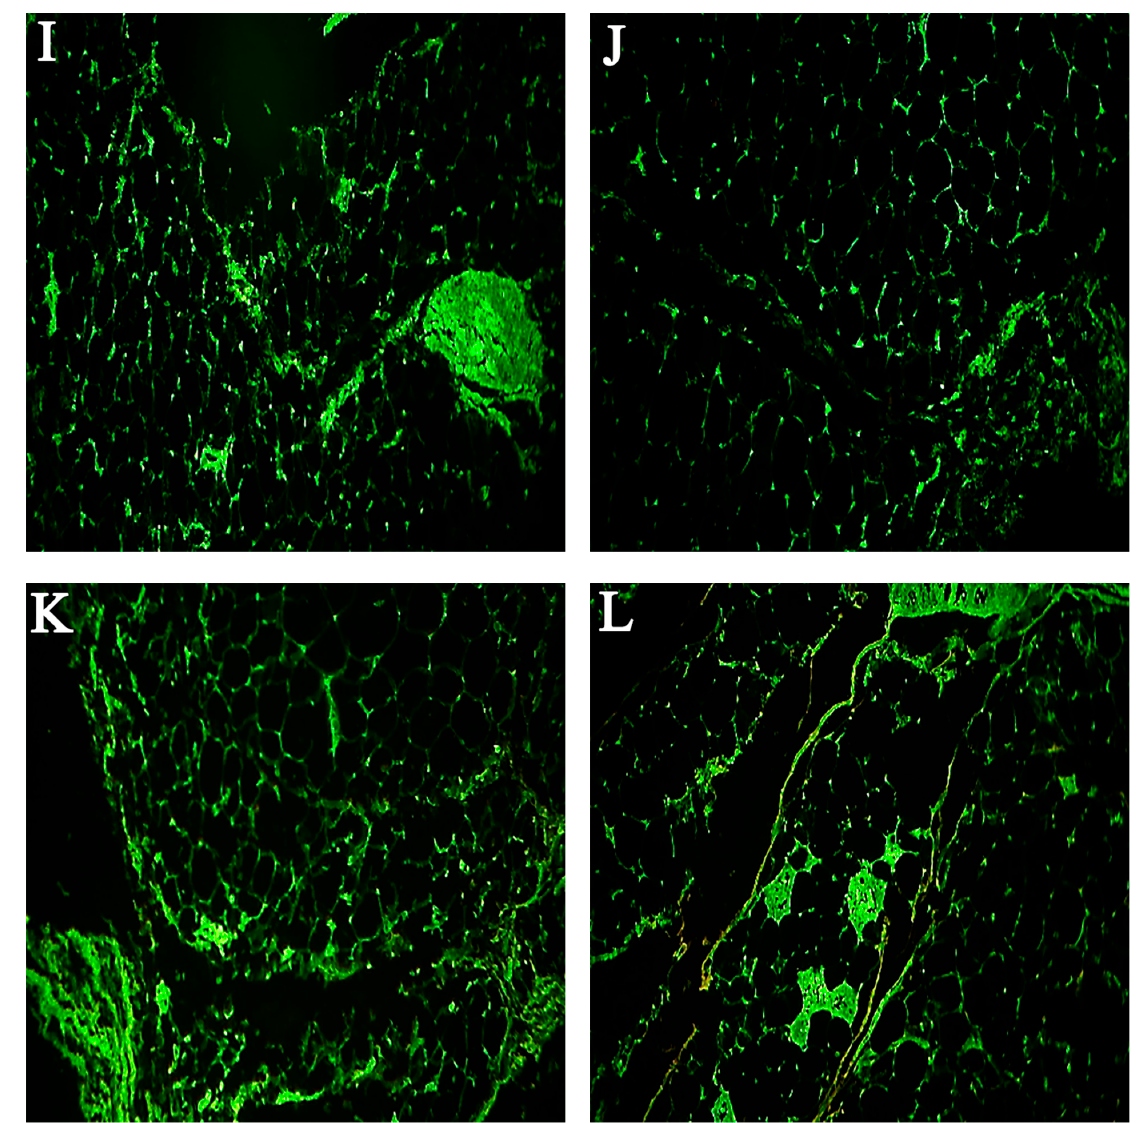
Figure 4. Fluorescence microscopy results of excised mass, revealing amyloid fibril deposits by Thioflavin-S staining. ( A – L ) are × 4 0 magnifications, where Sham1 ( A – C ), Sham2 ( D – F ), Exp1 ( G – I ), and Exp2 ( J – L ) are represented. In each group, results of 6, 12, and 18 days of injection are shown from left to right (e.g., A: 6 days, B: 12 days, C: 18